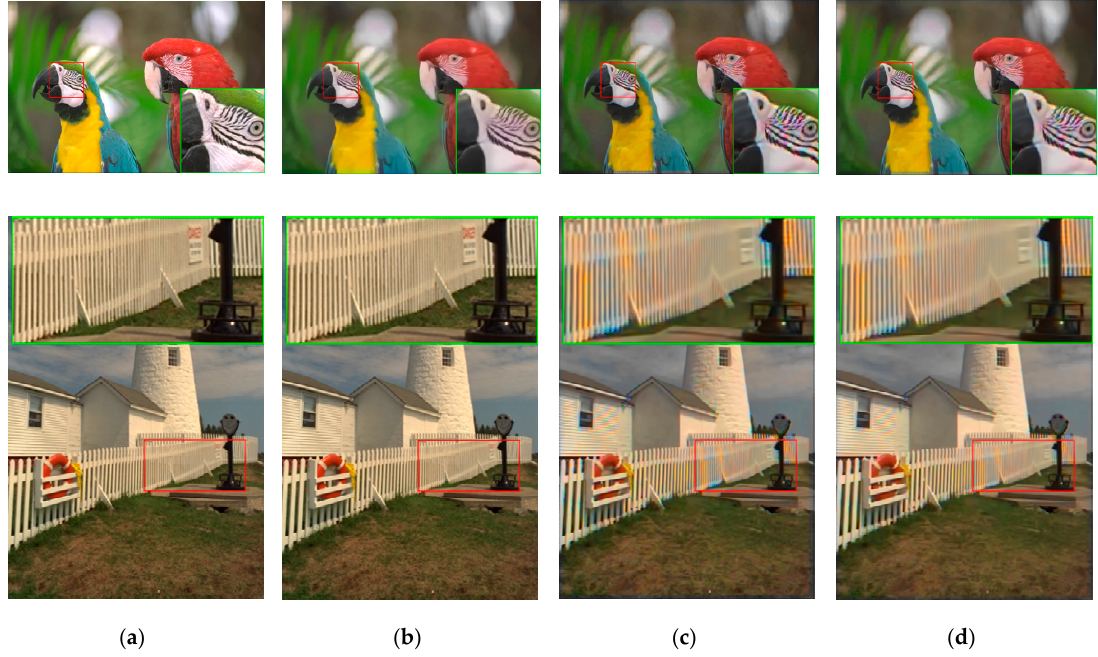
Figure 13. Visual comparison of three high performing demosaicing algorithms at 10 dBs SNR (Poisson noise). The top row is the bird image and the bottom row is the lighthouse image. ( a ) Ground Truth; ( b ) Demonet + GFPCA; ( c ) ATMF; ( d )